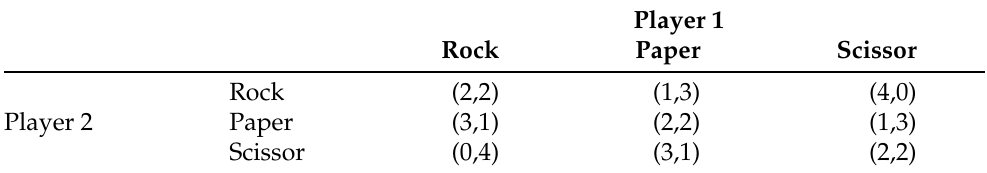
Table 1. The payoff (Player 1, Player 2) matrix